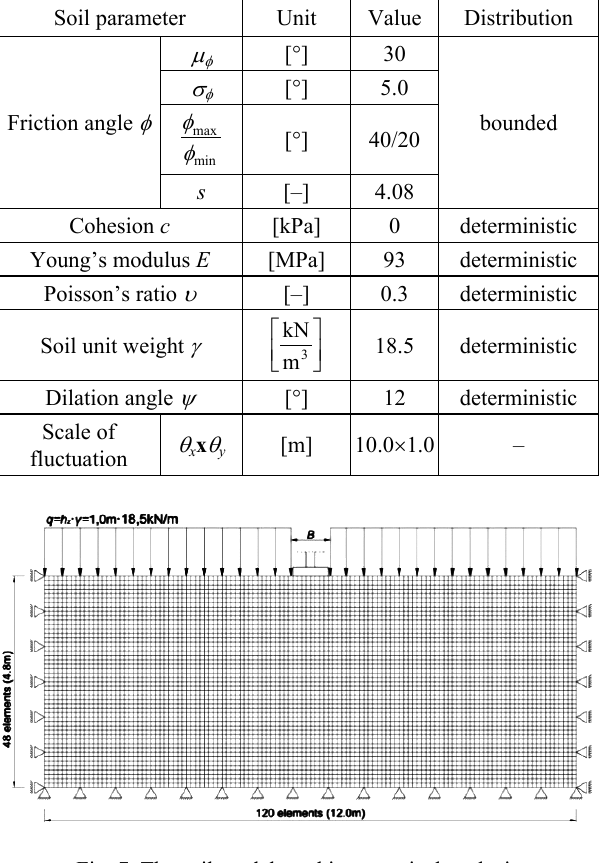
Fig. 7. The soil model used in numerical analysis of the bearing capacity of cohesionless soil